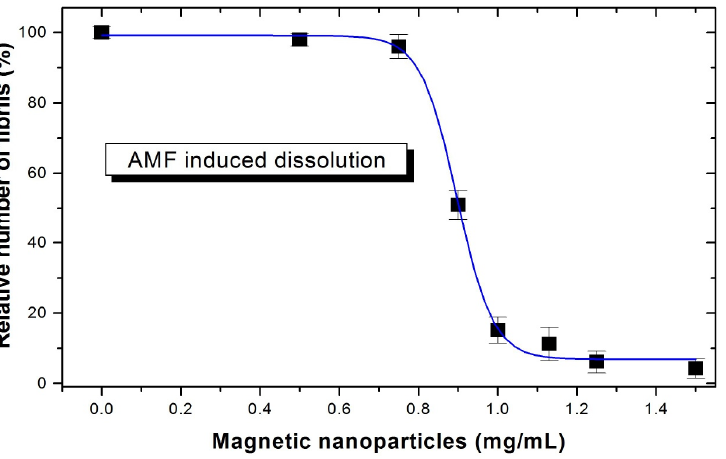
Figure 8. Relative number of fibrils after 15 min of applying an alternating magnetic field as a function of MN concentration. On the graph, rescaled values are presented for clarity, where 0% corresponds to pure CR and 100% corresponds to amyloid fibrils without nanoparticles and without the application of a magnetic field. Mean values and standard deviations from three independent ex ‐ periments.